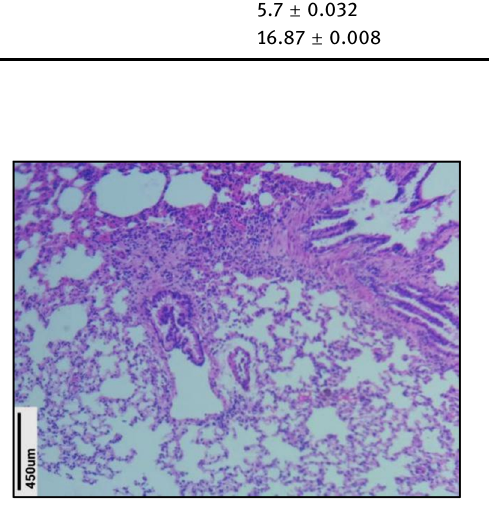
Figure 6: Histopathological study of Group VII lung section ( EHC - treated group ) . The EHC - treated group showed decreased in fl am - matory cell in fi ltration compared to sensitized group. The treatment with the EHC prevented hyperplasia and bronchoconstriction in sensitized + EHC - treated